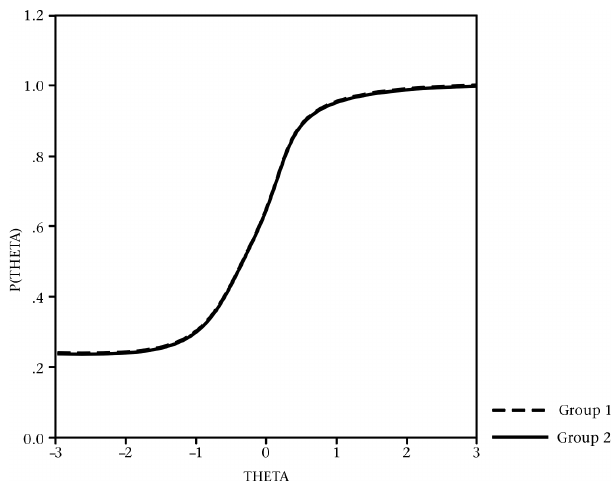
Figure 4: Item showing no